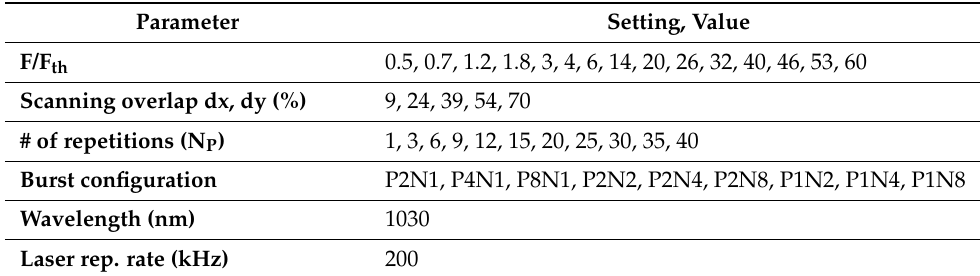
Table 1. Varied parameter settings in the experiments. Parameter Setting,